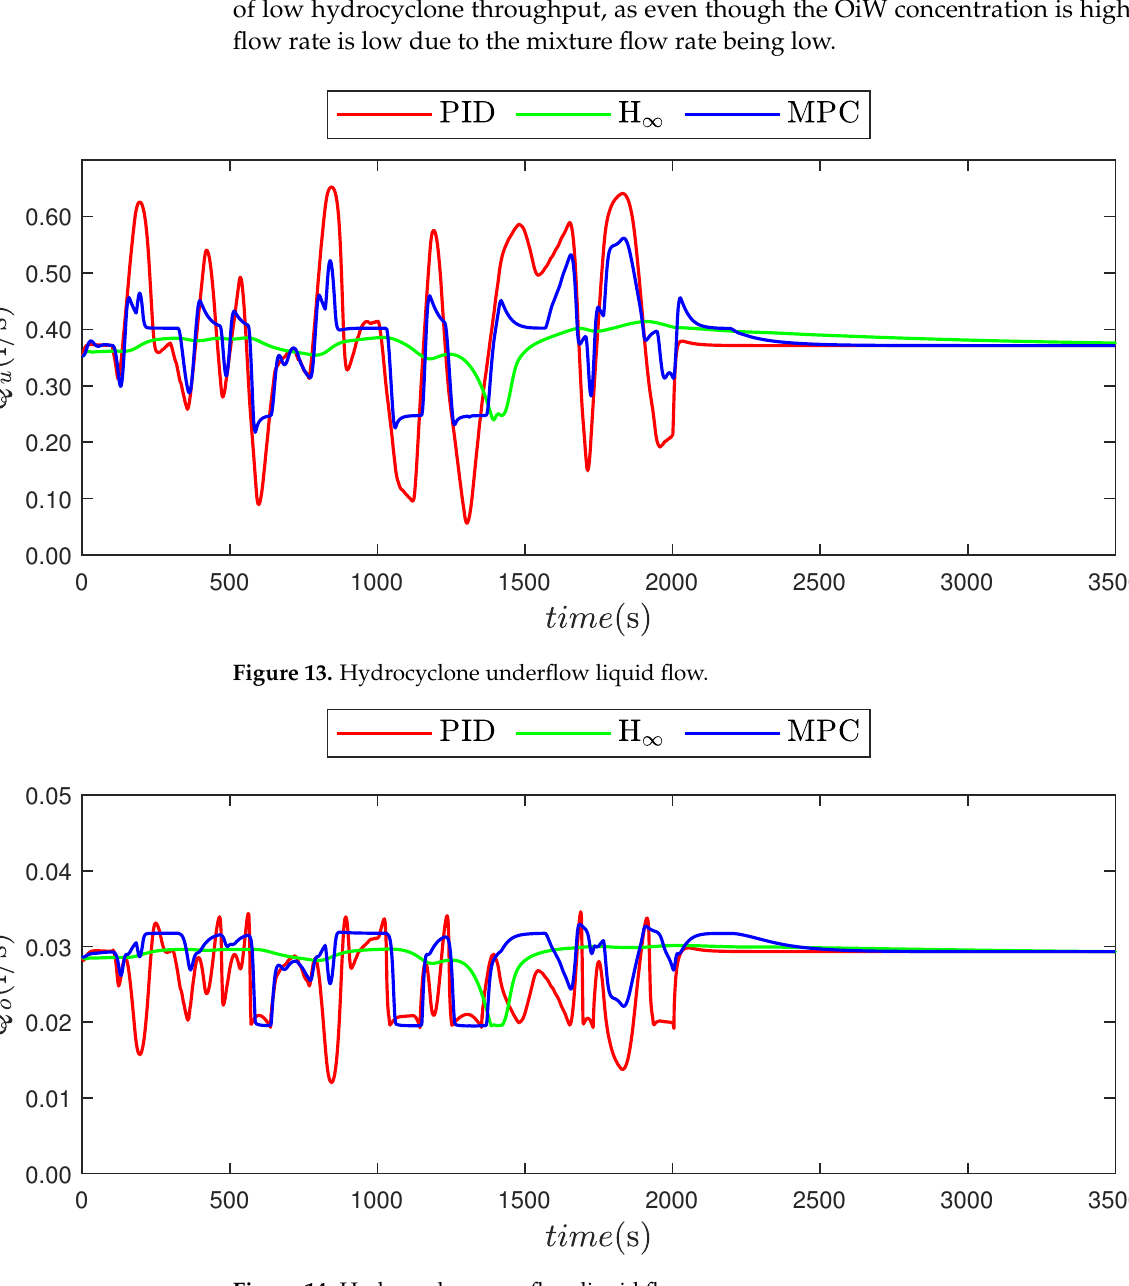
Figure 14. Hydrocyclone overflow liquid